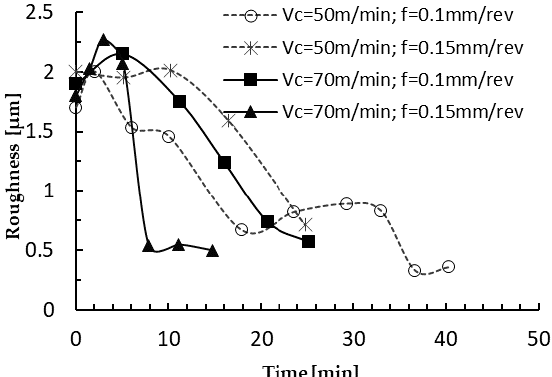
Figure 9. Average roughness (µm) in carbide tools.